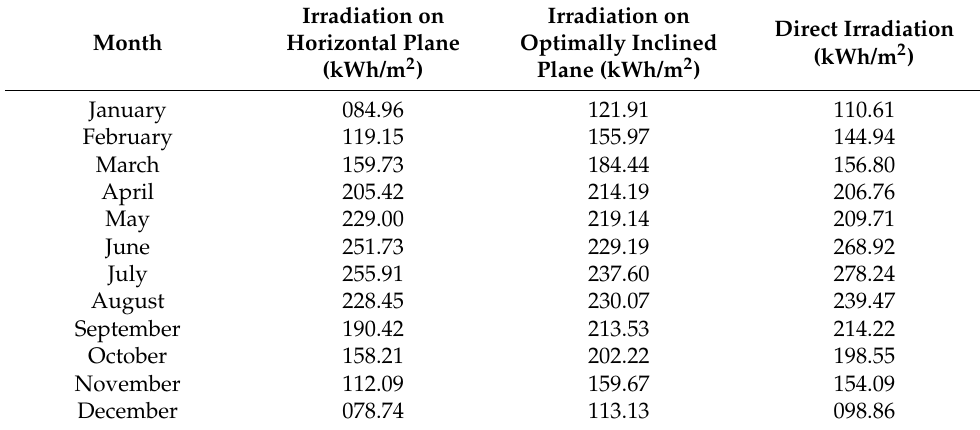
Table 4. Radiation data in